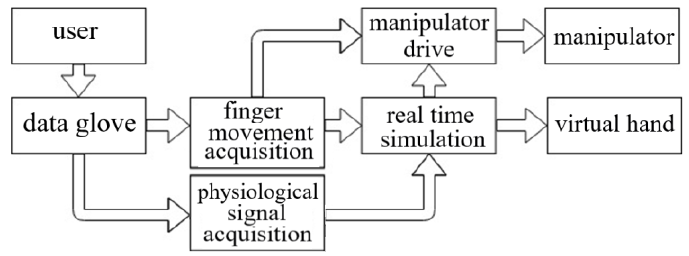
Figure 4. Design framework of data glove with emotion recognition function.